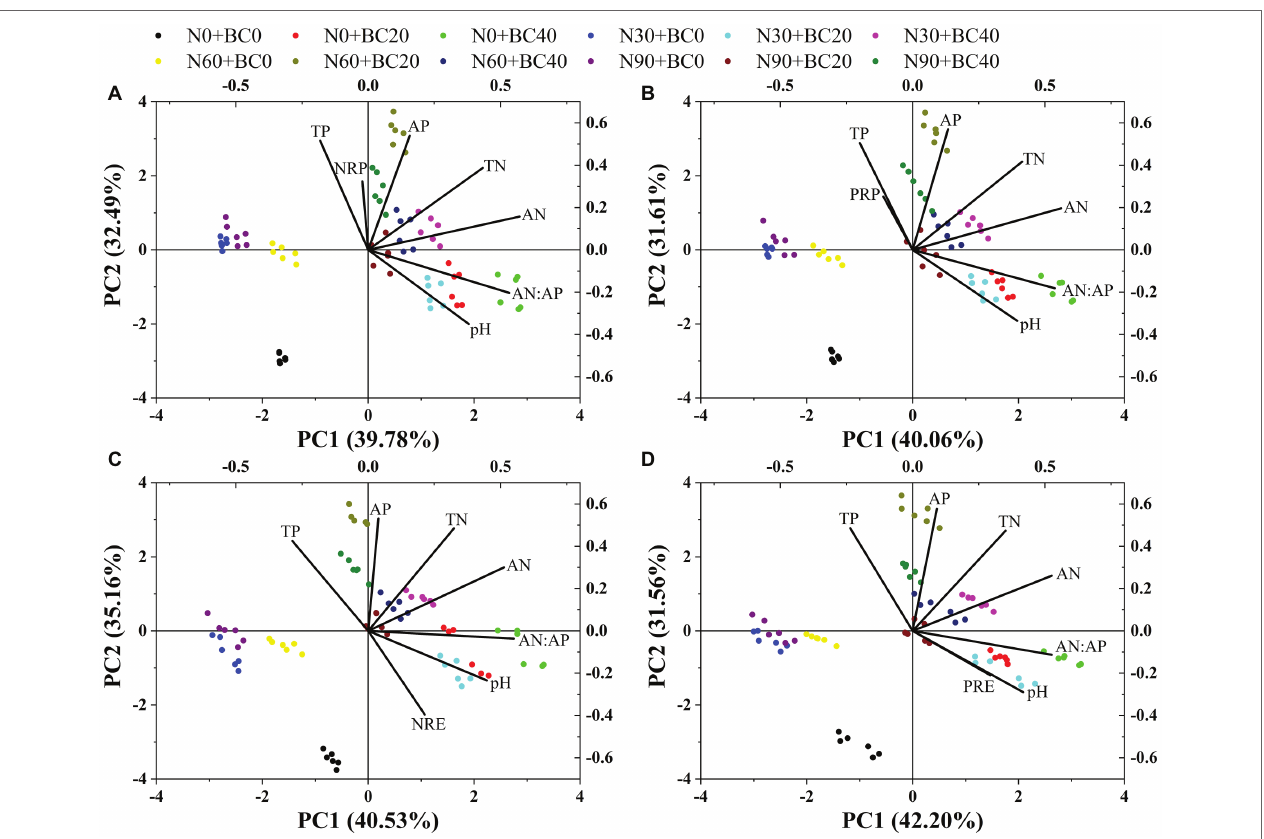
FIGURE 4 | Principal components analysis (PCA) of NRP (A) , PRP (B) , NRE (C) , and PRE (D) , and soil properties. TN, soil total nitrogen; TP, soil total phosphorus; AN, soil available nitrogen; AP, soil available phosphorus.